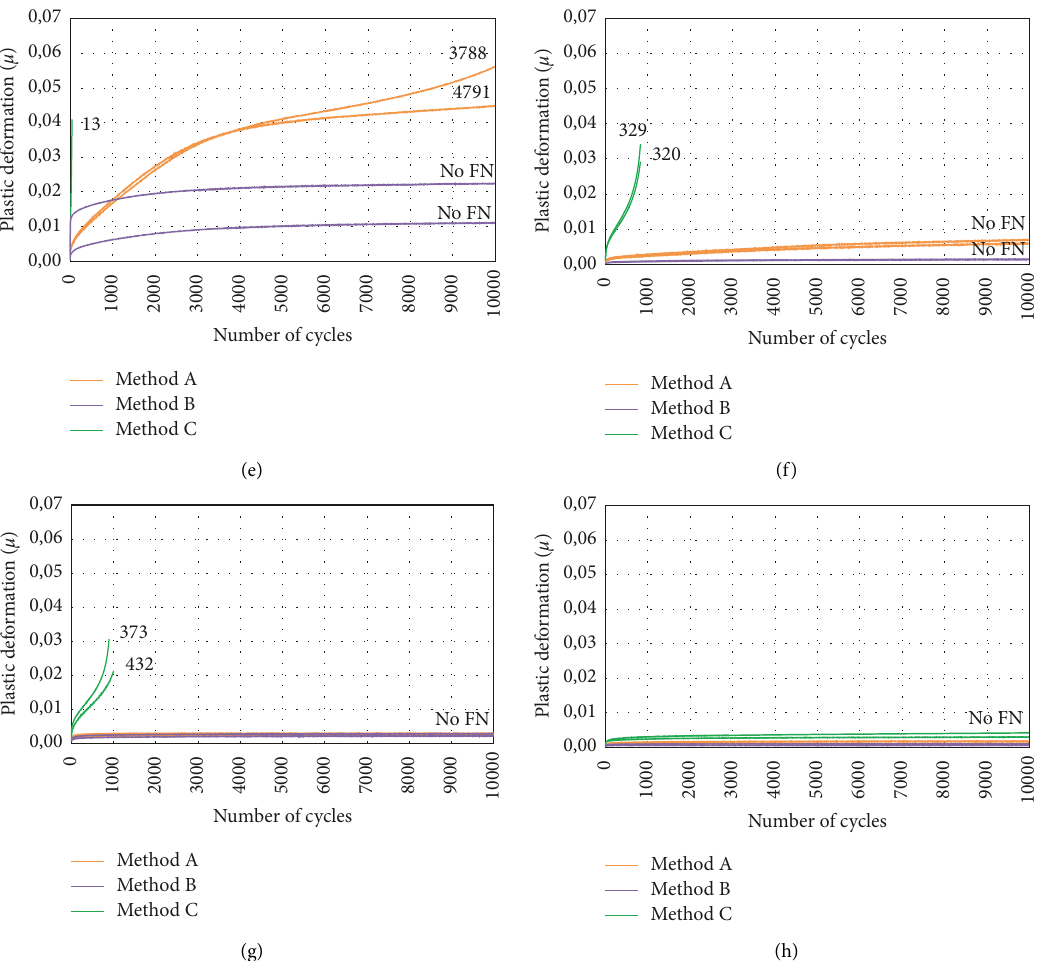
Figure 8: Flow number test results: (a) RAP_3E2C, 0-day curing; (b) RAP_3E2C, 28-days curing; (c) RAP_3F2C, 0,day curing; (d) RAP_3F2C, 28-days curing; (e) RAP_2F1H, 0-day curing; (f) RAP_2F1H, 28-days curing; (g) GCS_2F1H, 0-day curing; (h) GCS_2F1H, 28-days curing.